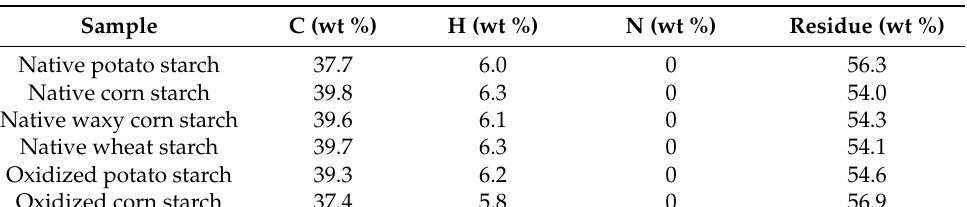
Table 1. Results of the elemental analysis for the different starches. Residue here describes the relative mass that was not attributed to the elements C, H, and N.